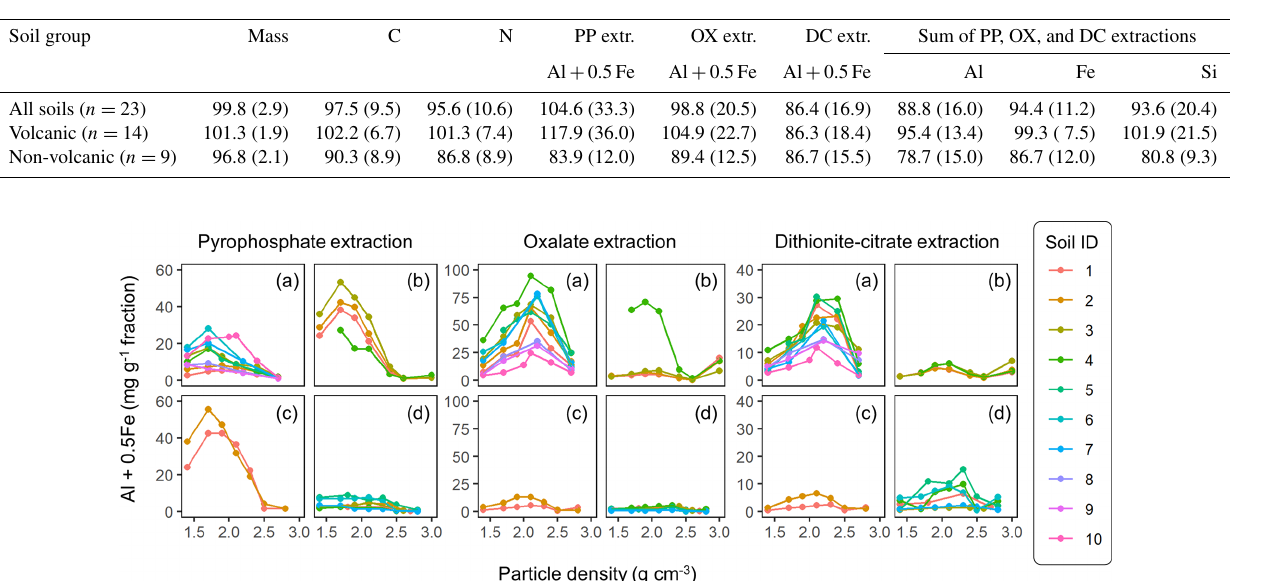
Table 2. Recoveries (percentages) of mass, C, N, and the metals dissolved by initial pyrophosphate (PP) and subsequent acid oxalate (OX) and dithionite–citrate (DC) extractions from the density fractions, expressed as percentage relative to the whole soil. Values show means (standard deviations) of all soils and separately for Andisols (allophanic and non-allophanic Andisols) and non-Andisols (Spodosols and crystalline mineral soils).